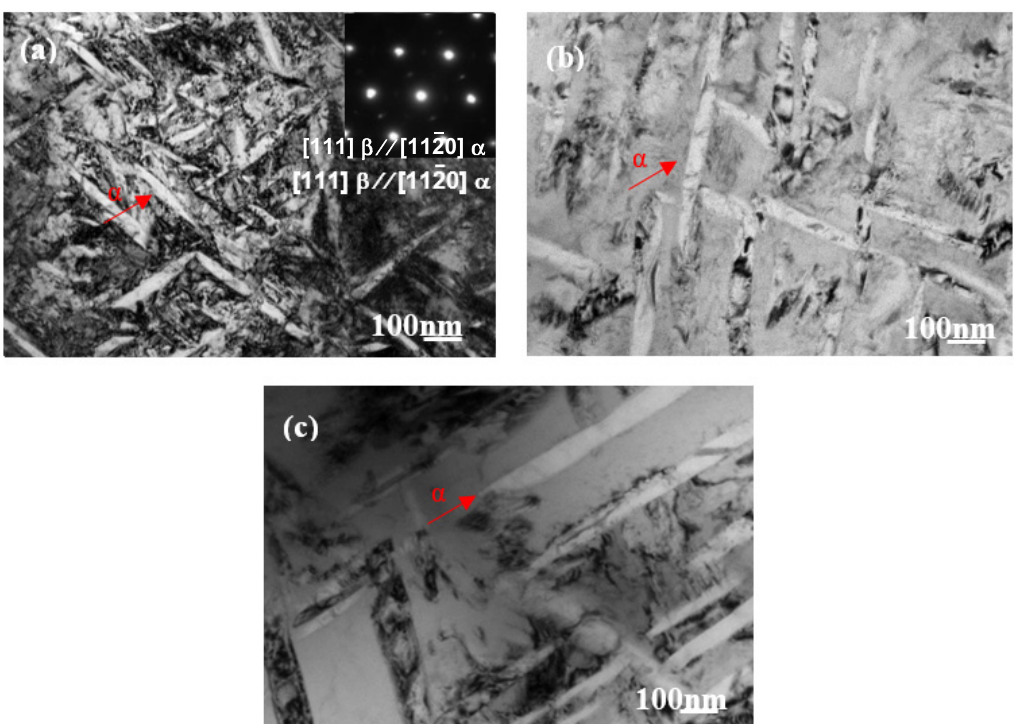
Figure 1. Microstructures of the alloy in different heat treatment conditions, ( a ) 800 °C/30 min + 500